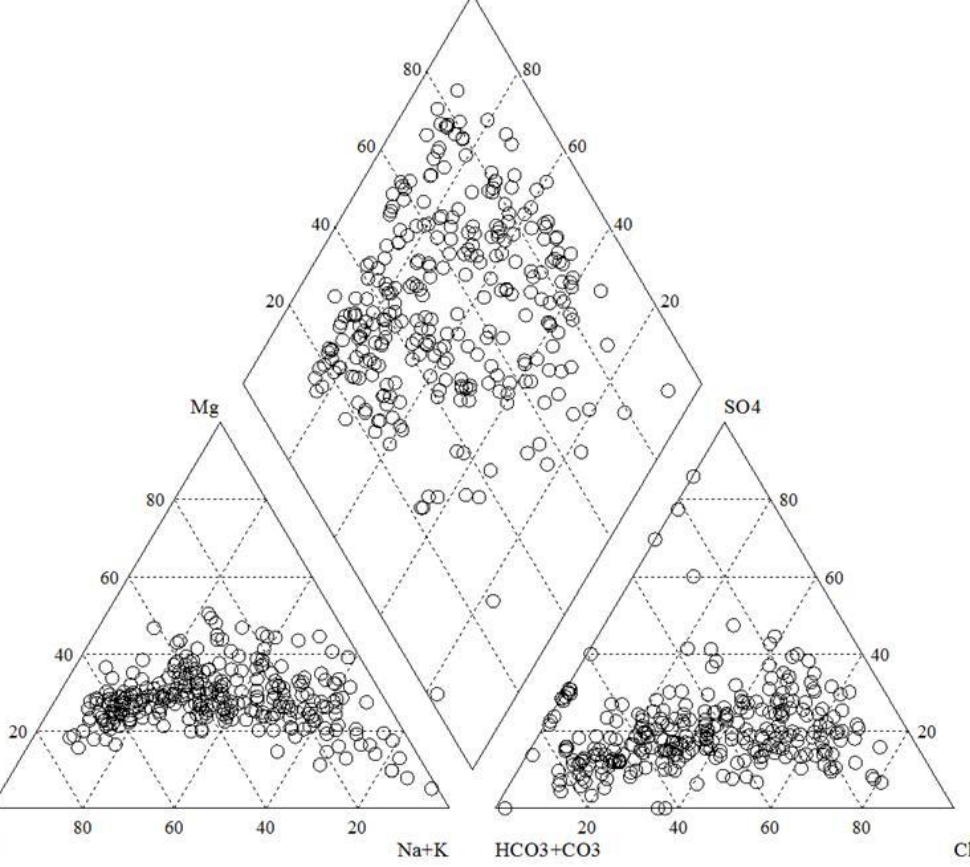
Figure 2. Piper trilinear diagram of the chemical types of groundwater in the Chahannur Basin.